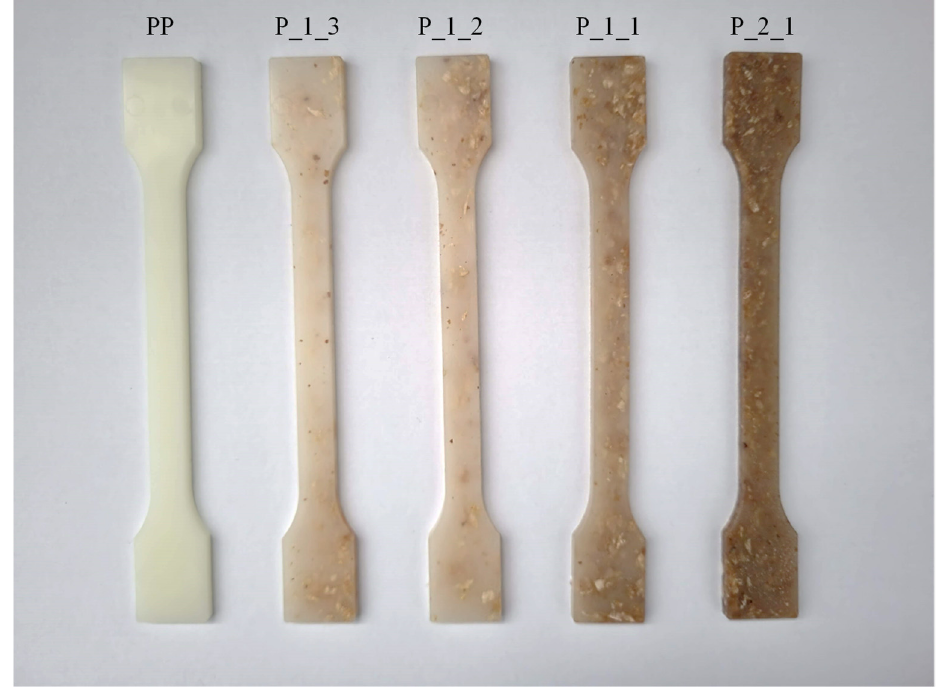
Figure 2. Test specimens obtained by injection method.